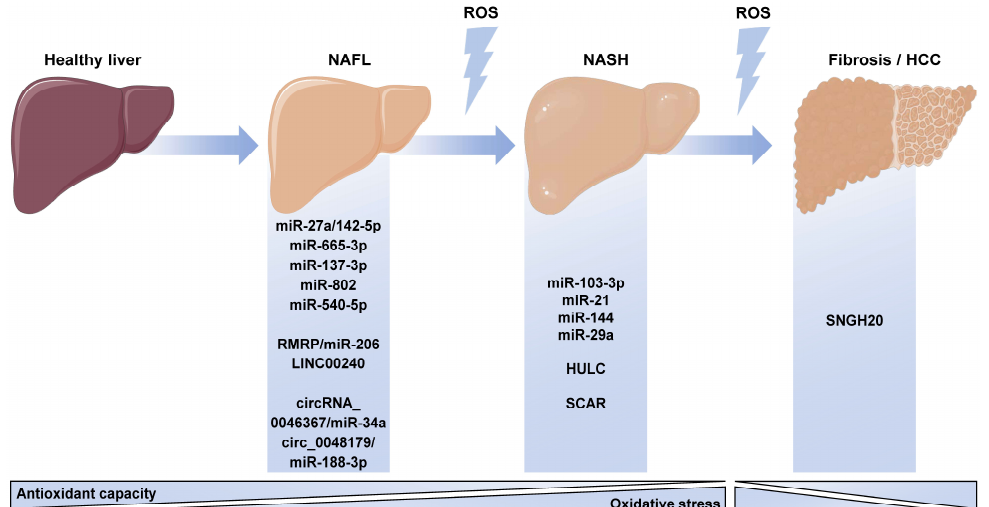
Figure 3. Each stage in the progression on NAFLD is related to disturbances in the pro-oxidant and antioxidant mechanisms, both of which are regulated by ncRNAs. In each stage, miRNAs, lncRNAs, and circRNAs that regulate oxidative stress and display altered expressions are highlighted. NAFL: non-alcoholic fatty liver, NASH: non-alcoholic steatohepatitis, ROS: reactive oxygen species, HCC: hepatocellular carcinoma. This figure has been edited from Servier Medical Art. Servier is licensed